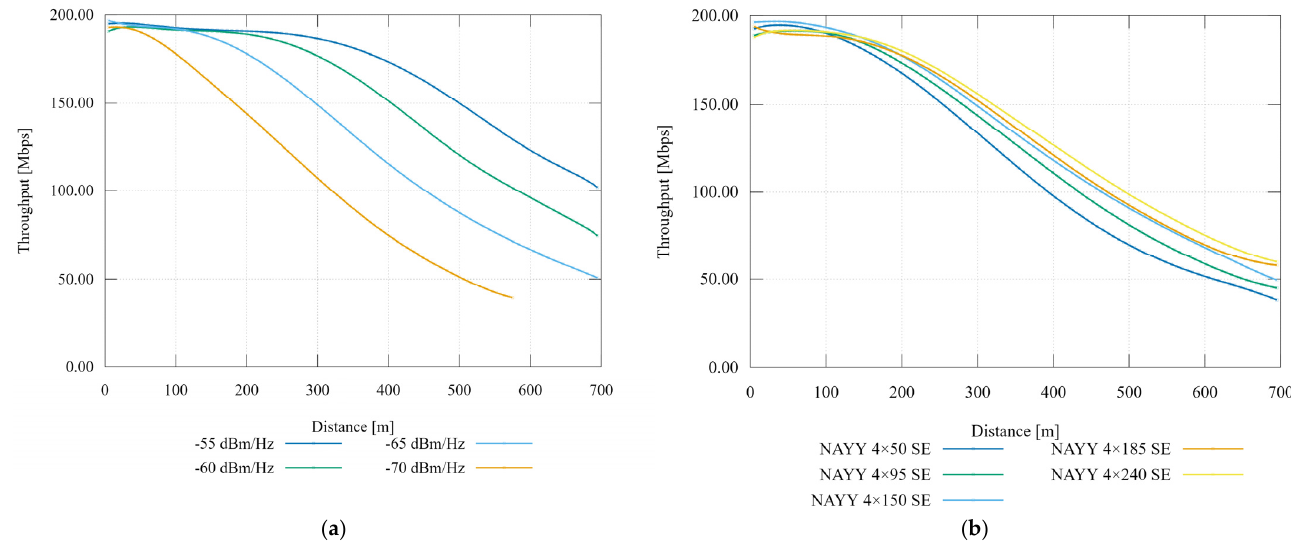
Figure 8. ( a ) Comparison of throughput with transmit PSD sweep; ( b ) Comparison of throughput with cable cross-section sweep.